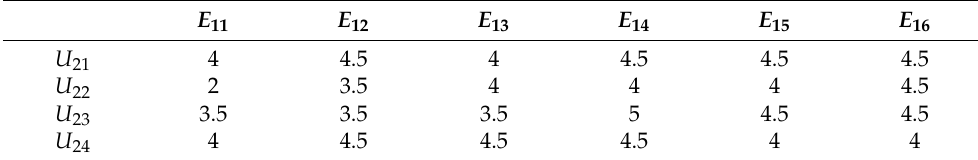
Table 5. The importance score of U 21 , U 22 , U 23 , and U 24 .